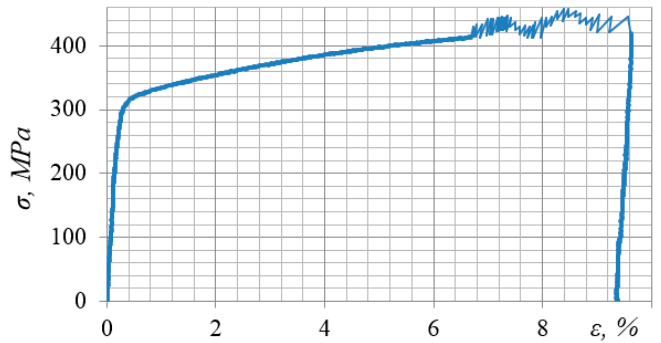
Figure 6. Stress-strain diagram of steel 12Kh17 in the process of preliminary static loading and in the process of impulse introduction of energy (F imp = 120 kN).